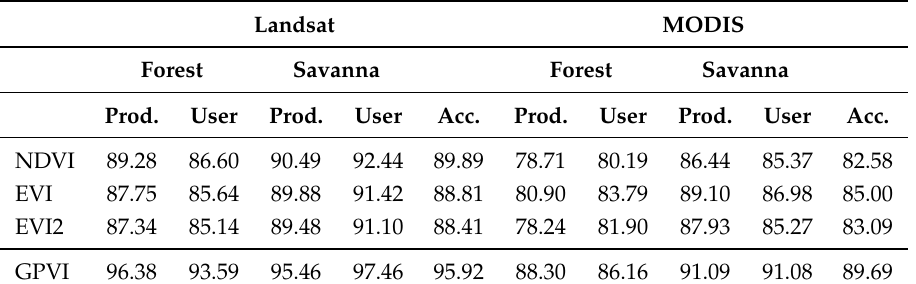
Table 3. Normalized accuracy ( Acc. ) and user’s ( User ) and producer’s (Prod.) accuracy per class for forest/savanna